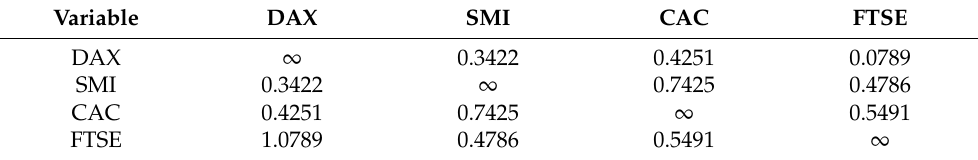
Table 2. Fitted copula parameter α for the bivariate KW (Type I) copula.